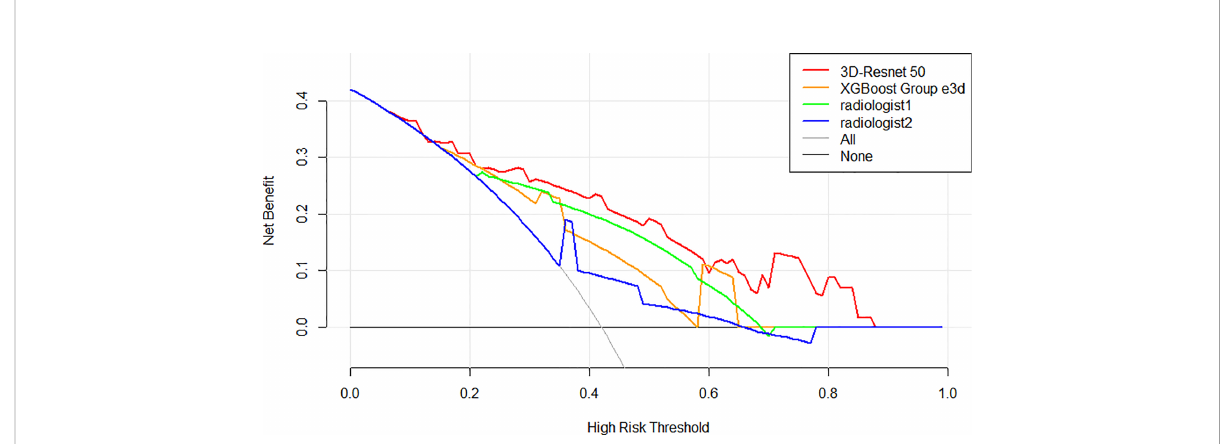
FIGURE 5 Decision curve analysis (DCA) of the models and radiologists from the test cohort. The net bene fi t measured on the y -axis is determined by calculating the difference between the expected bene fi t and the expected harm associated with each proposed model. The red curve, green curve, orange curve, and blue curve represent the performance of the 3D-Resnet-50 model, the best XGBoost model, radiologist 1, and radiologist 2, respectively. The gray line represents the assumption that all lesions were malignant (the treat-all scheme). The black line represents the assumption that all lesions were benign (the treat-none scheme). If the threshold probability was more than 7%, using the 3D- Resnet-50 model to predict malignancy added more bene fi t than either the treat-all scheme or the treat-none scheme (dark black